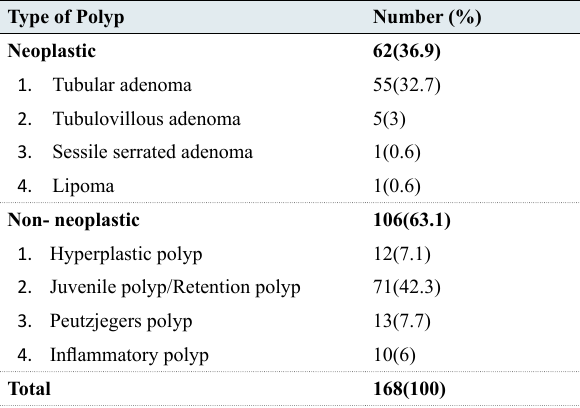
Table 1: Histological types of polypoidal lesions Type of Polyp